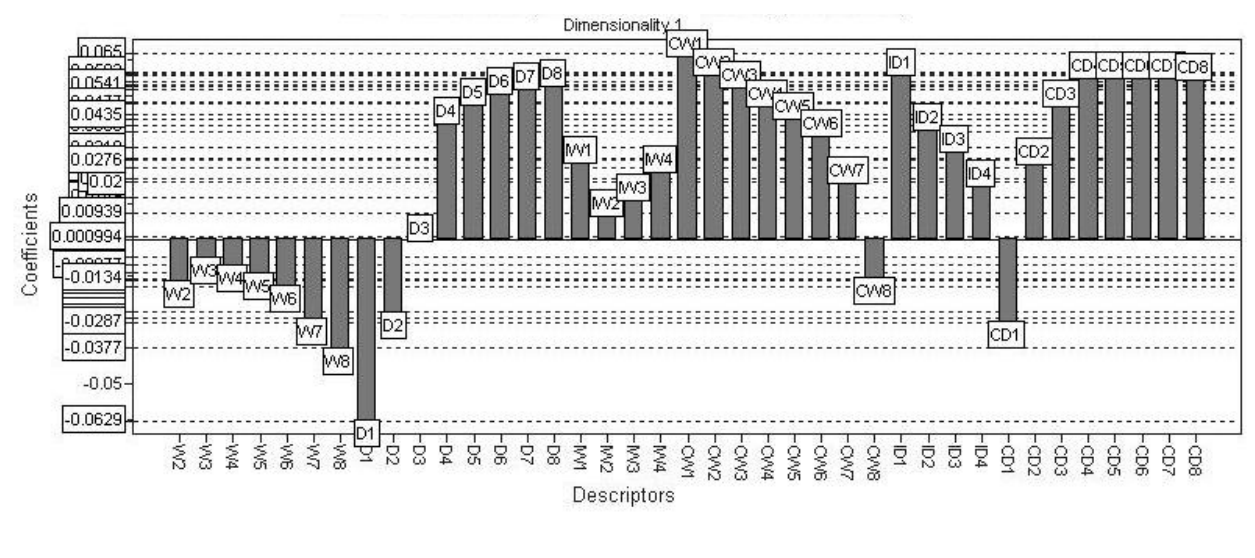
Figure 7. Coefficients plot generated from the selected PLS